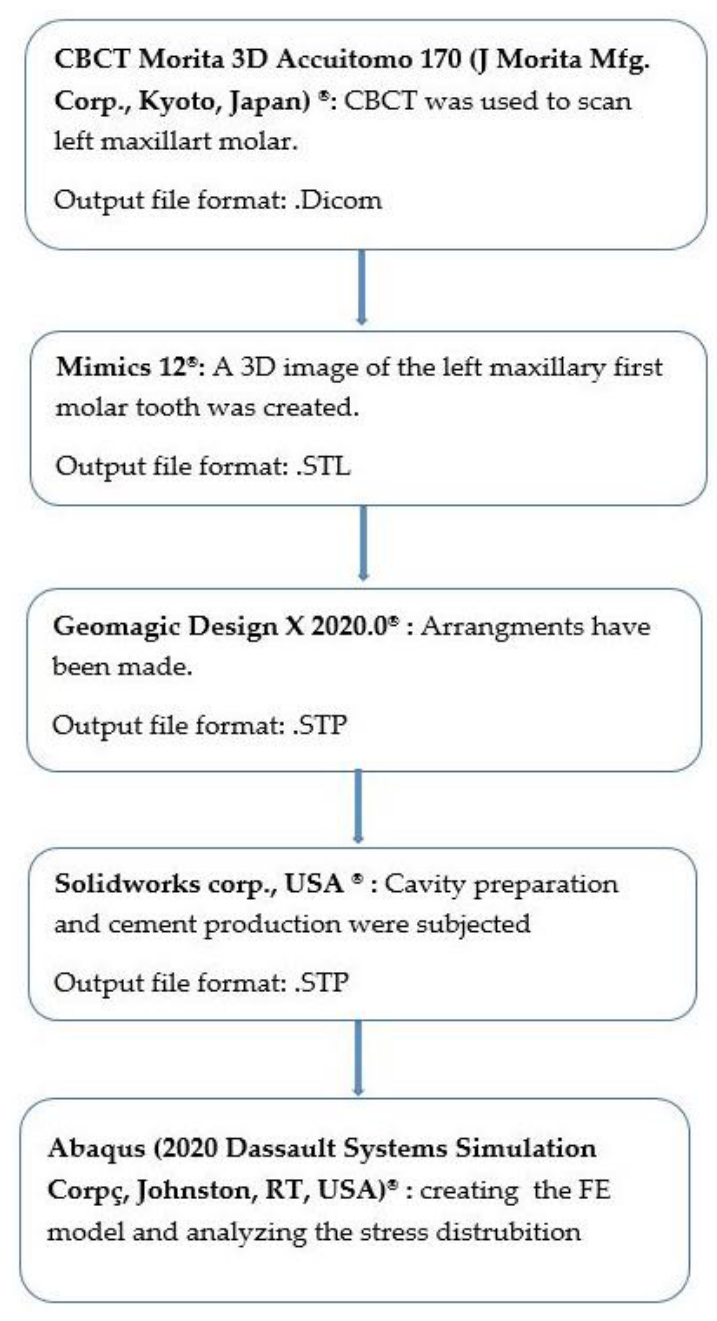
Figure 1. Flowchart for performing finite element analysis.